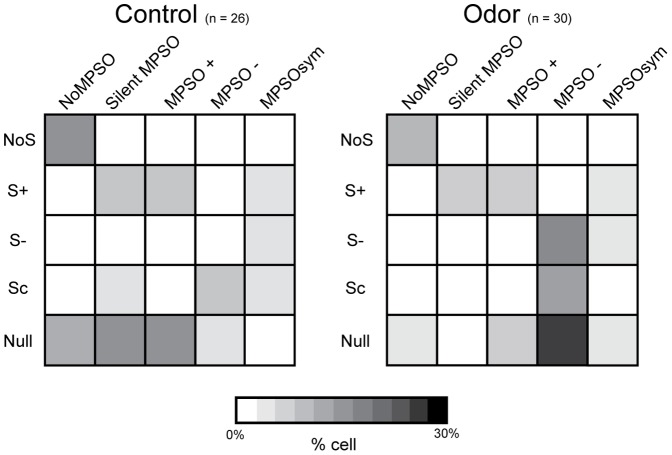
Exclusive associations between membrane potential slow oscillations and respiration-related discharge patterns.The cell percentages exhibiting an association between each type of membrane potential slow oscillation (including silent membrane potential slow oscillations, silent MPSOs) and each type of respiration-related discharge pattern are shown for the control (n = 26) and odor periods (n = 30). The cells that were used to create theses matrices are the same as those used in Figures 2 and 3. For the cells with NoMPSOs or silent MPSOs, only those that were tested using the intracellular excitability protocol were conserved. The cell percentages are represented using a grayscale code, in which white indicates a null percentage and black indicates 30% of the entire population. NoMPSO: no oscillation; silent MPSO: silent membrane potential slow oscillation; MPSO+: positive membrane potential slow oscillation; MPSO-: negative membrane potential slow oscillation; MPSOsym: symmetric membrane potential slow oscillation; NoS: non-synchronized pattern, S+: excitatory-simple-synchronized pattern; S-: suppressive-simple-synchronized pattern; Sc: complex synchronized pattern; Null: null activity.